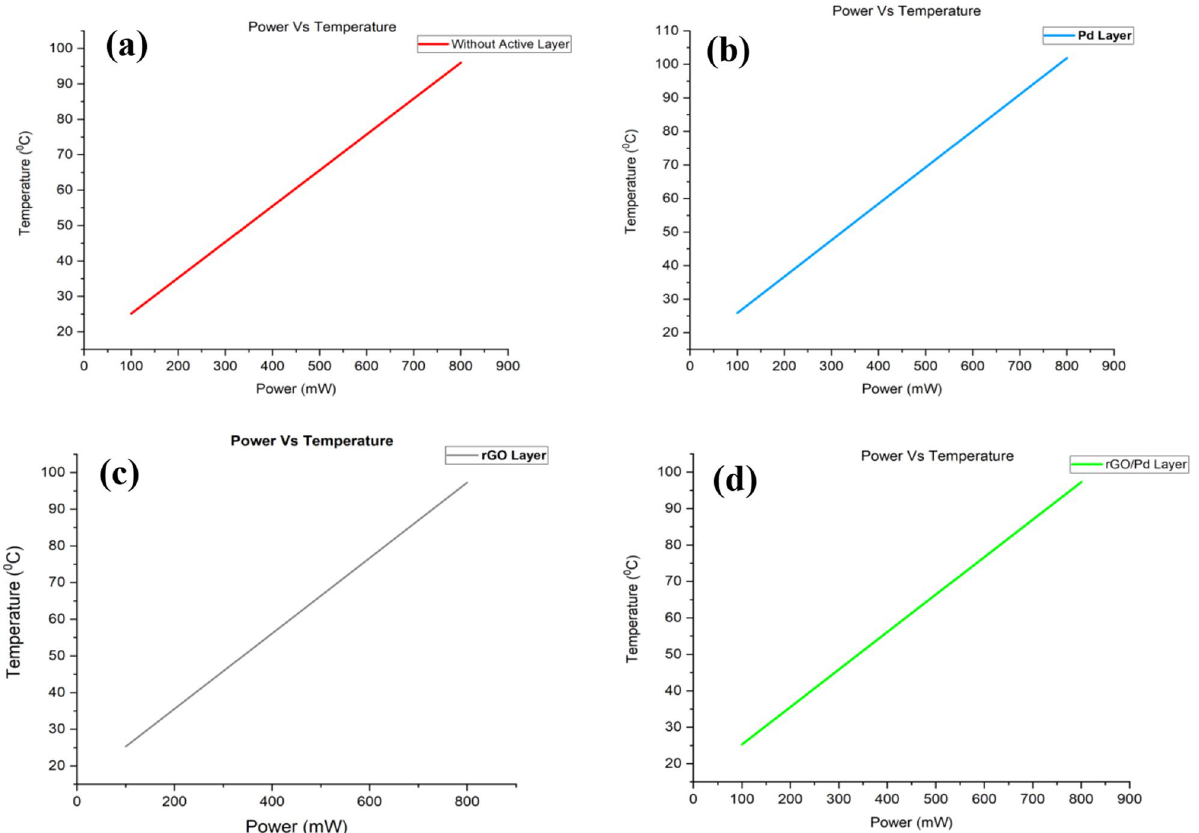
Figure 5. The operating temperature versus applied power curves of substrates used in the simulation of chemical gas sensors: ( a ) SnO 2 thin film ( b ) SnO 2 –Pd ( c ) SnO 2 –rGO and ( d ) SnO 2